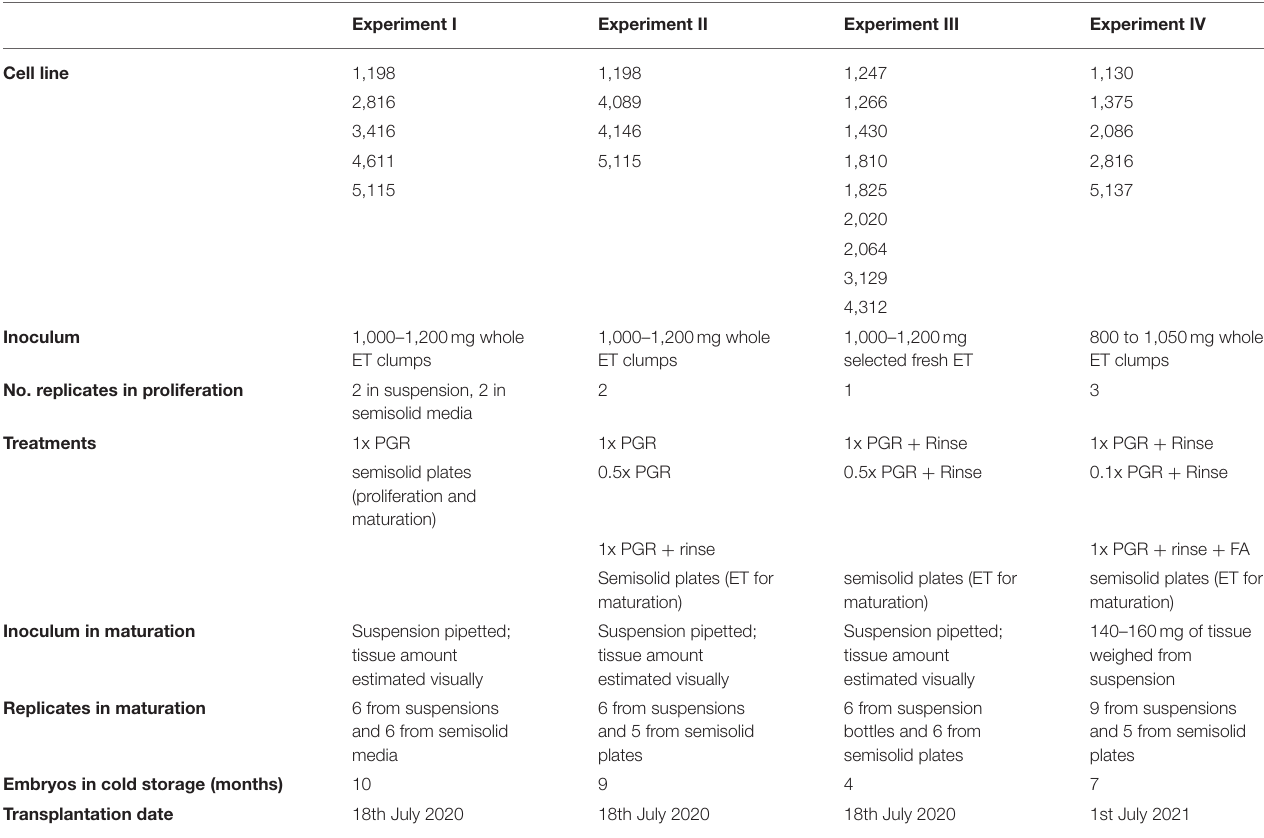
TABLE 1 | Information on lines and treatments used in each